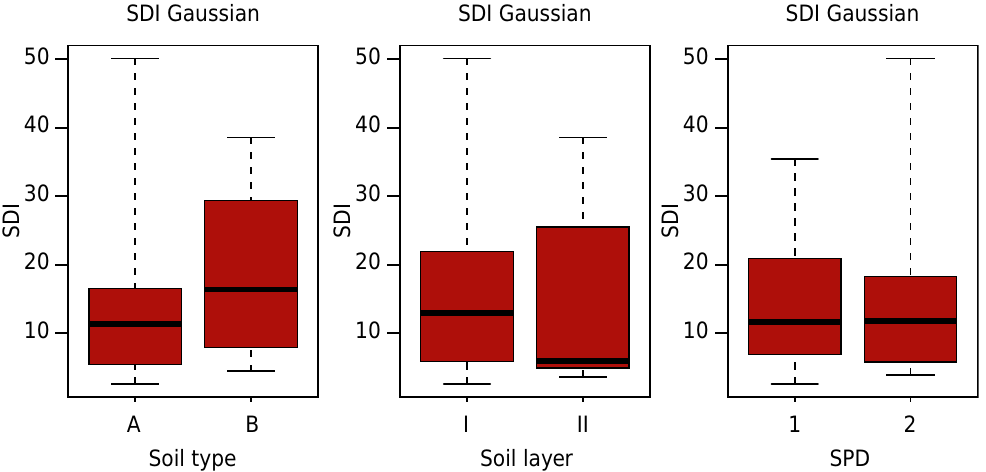
Figure 4. Boxplot graphs of the distribution of the SDI for the Gaussian model in different soil types, soil layers, and spatial dependencies, obtained from real data. Soil type: A = Oxisol (n = 70), B = Others (n = 40). Soil layer: I = Surface layer (0.0-0.1, 0.0-0.15, 0.0-0.2, 0.0-0.3 m) (n = 71), II = Bottom layer (0.1-0.2, 0.2-0.4, 0.4-0.6 m) (n = 30). SPD: 1 = 0 ≤ SPD ≤ 75 % (n = 53), 2 = SPD > 75 % (n =